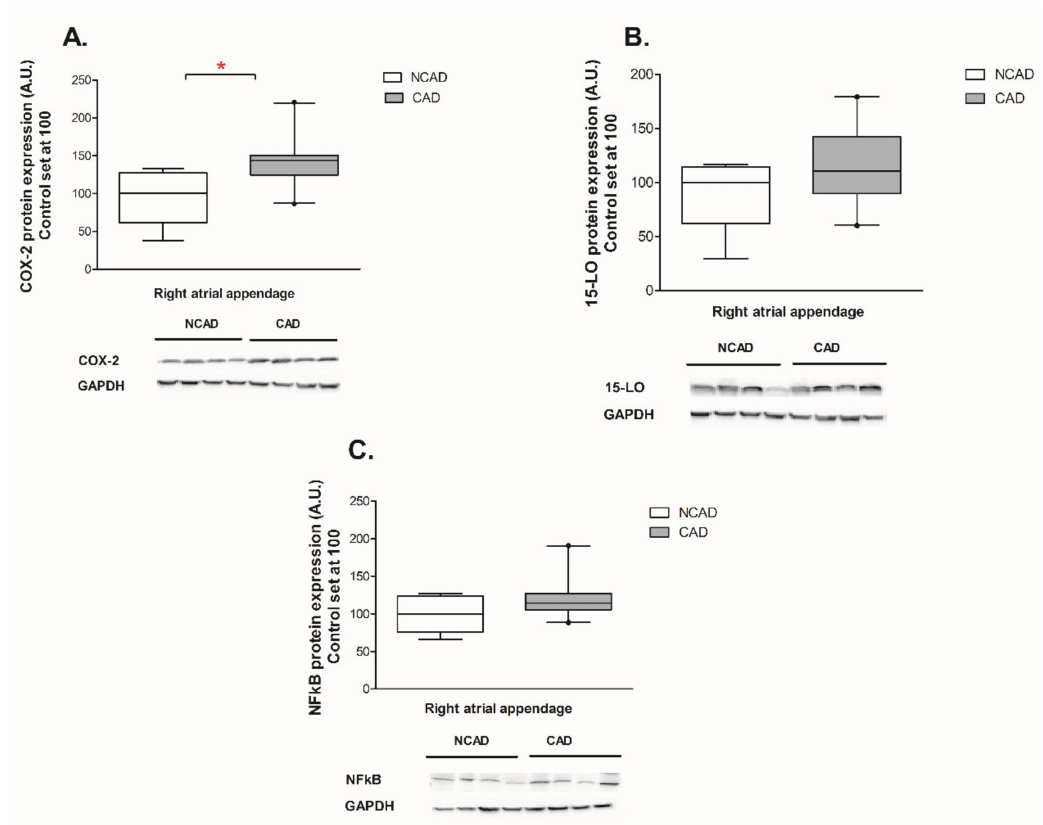
Figure 8. Myocardial proteins expression of ( A ) Cyclooxygenase-2 (COX-2), ( B ) lipoxygenase (15-LO), ( C ) nuclear factor kappa B (NF κβ ) in the coronary atherosclerosis (CAD, n = 24) and control (NCAD, n = 11) patients. The number of subjects with atherosclerosis studied was smaller than the number assayed previous determinations due to an insu ffi cient amount of the muscle tissue available. Representative bands of WB analysis were shown. The inner horizontal line of a box represents the median. Box boundaries: 25–75 percentile; whiskers 5–95 percentile. Data are expressed as median ± SEM. For the sake of clarity, the control group median was set at 100, and the CAD group was scaled with respect to NCAD. * p < 0.05 vs. control